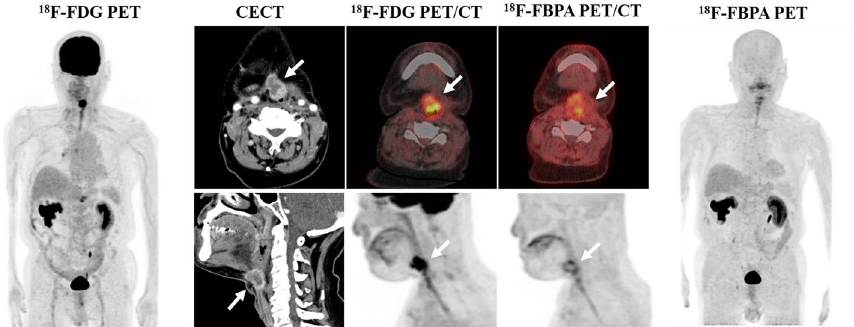
Fig. 6 A 75-year-old man underwent contrast-enhanced CT to confirm local recurrence of hypopharyngeal cancer after radiotherapy. Clinically, post-treatment changes (granulation tissue, radiation necrosis) were suspected, but both 18 F-FDG (SUVmax: 13.0) and 18 F-FBPA (SUVmax: 5.8) PET/CT showed increased accumulation. Local recurrence was confirmed pathologically by puncture